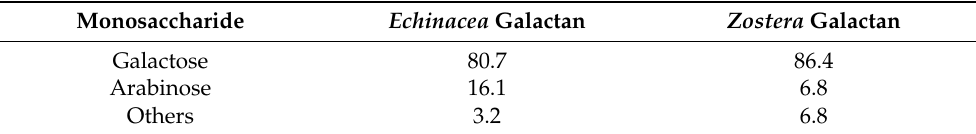
Table 1. Neutral monosaccharide composition of galactans. Values are given in % (mol/mol).